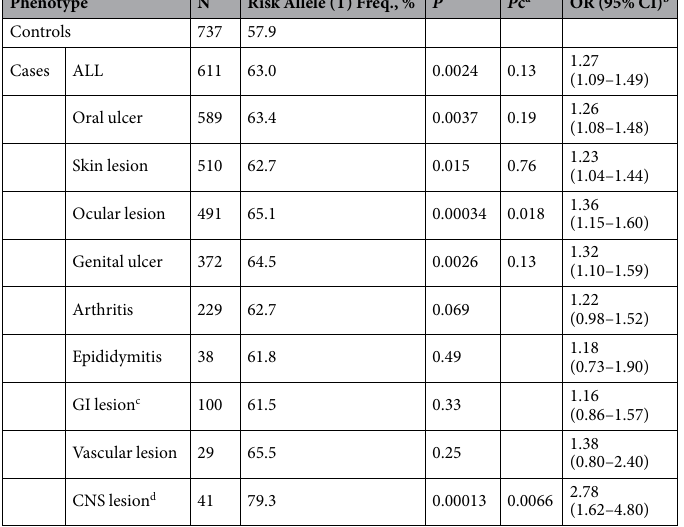
Table 2. Allelic association results between rs9517723 and clinical symptoms of Behçet’s disease. a P c, corrected P . b OR, odds ratio; CI, confidence interval. c GI, gastrointestinal. d CNS, central nervous